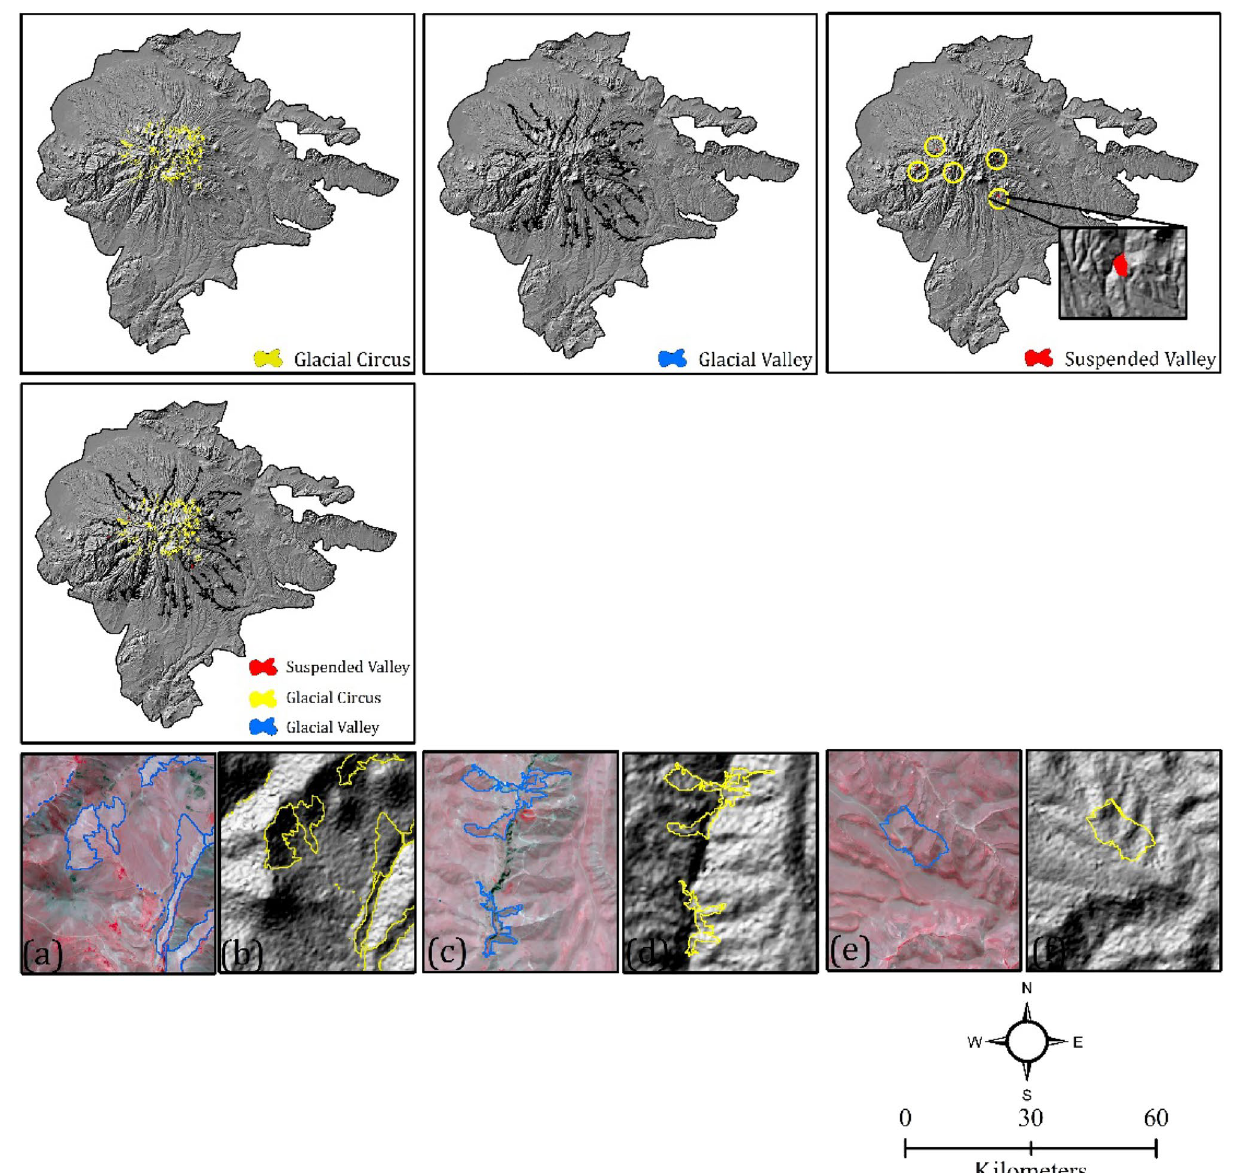
respectively, and ( e , f ) suspended valley on Sentinel-2 and curvature,